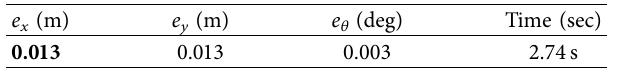
Figure 16: Estimation error for the PF with one landmark and non- Gaussian noise. Table 11: The mean of the estimation errors for the PF (one landmark and non-Gaussian